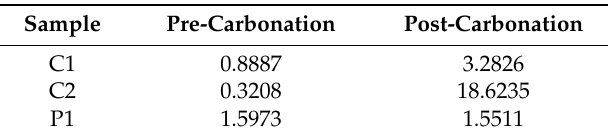
Table 5. The BET surface area of CFBC bottom ash and pulverized coal-fired (PC) bottom ash samples, pre-carbonation and post-carbonation (m 2